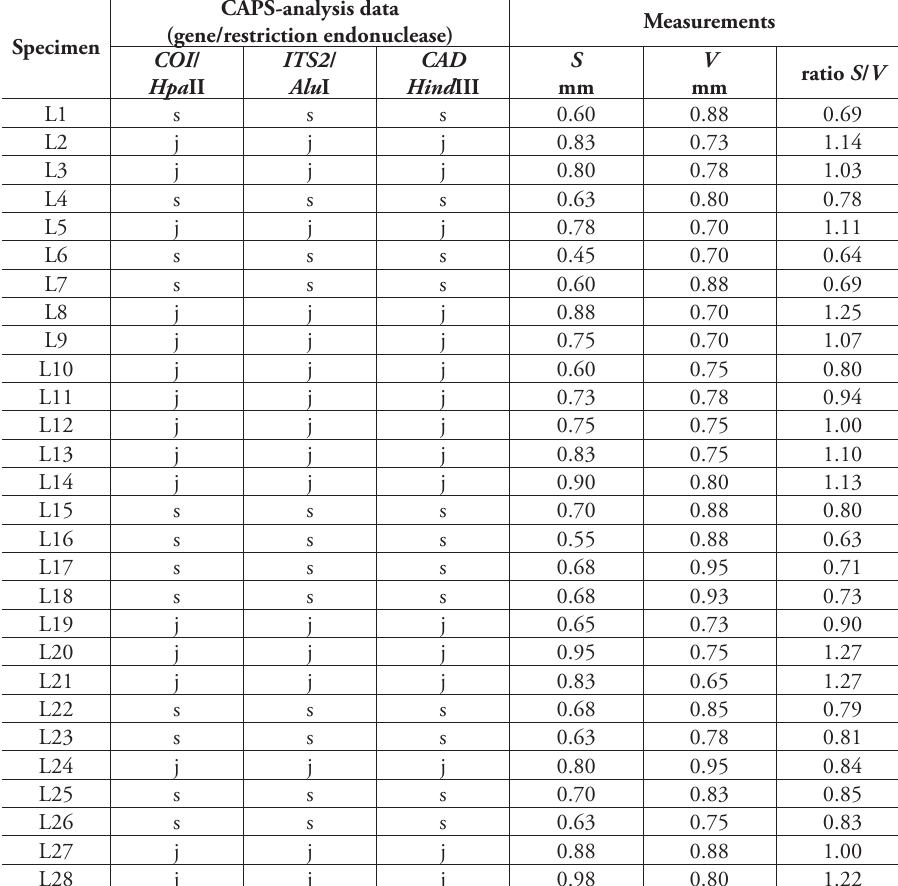
Table 5. CAPS-analysis data, the lengths of the saccus ( S ), valve ( V ) and their ratio ( S / V ) in males of L. sinapis and L. juvernica